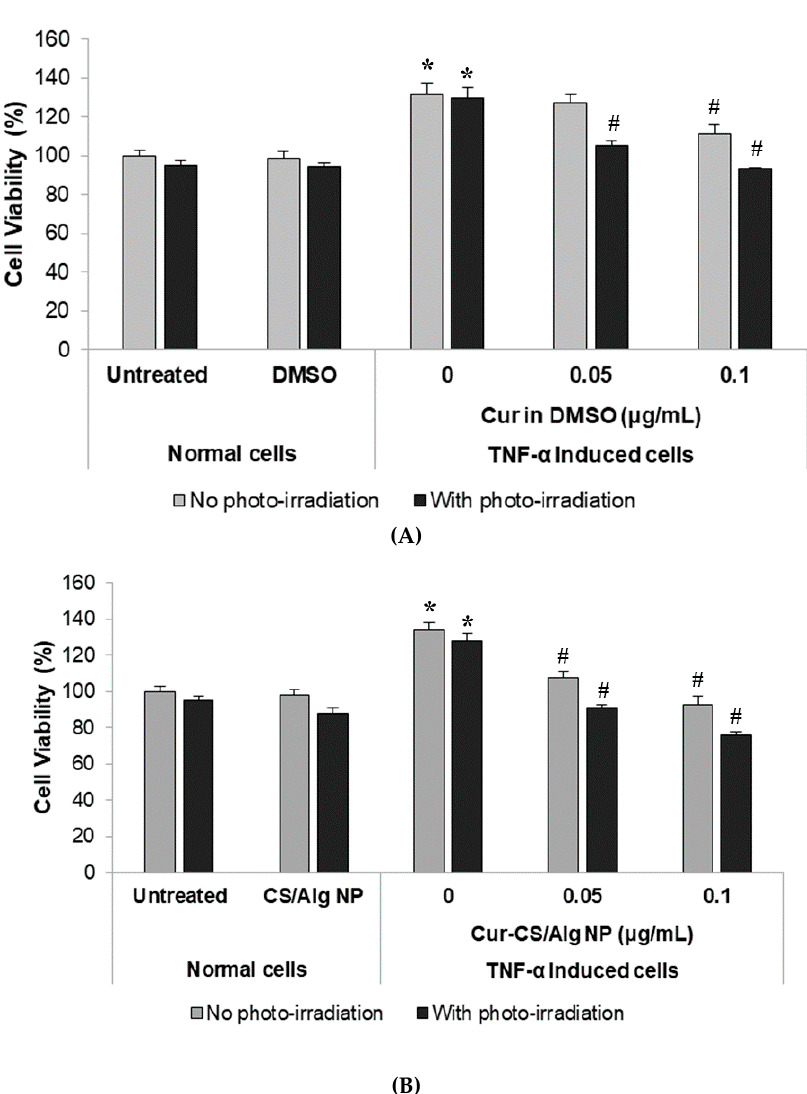
Figure 2. Induction of psoriasis-like proliferation of HaCaT cells by TNF- α and inhibition of the TNF- α -induced cell proliferation after treatment with ( A ) curcumin in DMSO and ( B ) Cur-CS/Alg NPs at 0.05 µ g/mL and 0.1 µ g/mL with and without photo-irradiation (10 J/cm 2 ). Controls for free curcumin and Cur-CS/Alg NPs were DMSO and CS/Alg NPs, respectively. Data are presented as the mean ( ± SD) relative number of viable cells compared to the untreated control group (100%), and are derived from four replications. * p < 0.05 indicates significant differences from the untreated normal cells, # p < 0.05 indicates significant difference from the TNF- α -induced cells treated with the control (DMSO or empty CS/Alg NPs).